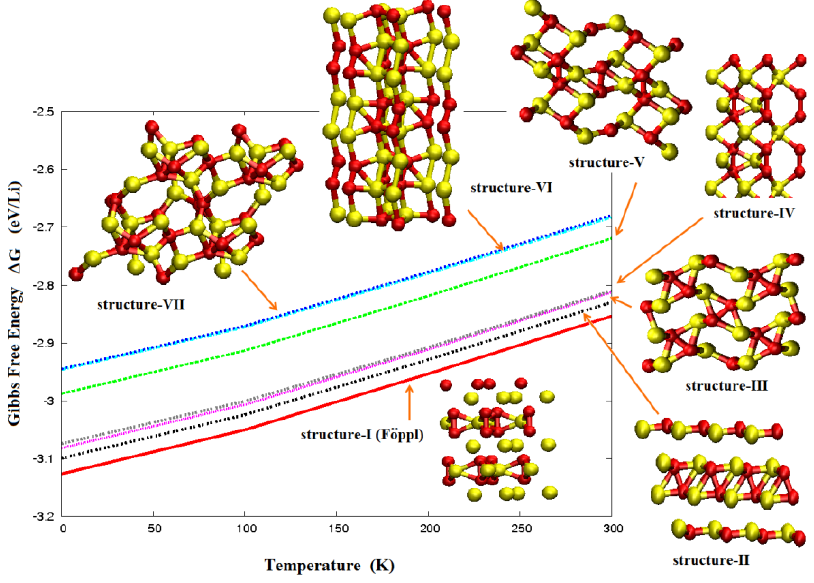
Figure 2. Selected Li 2 O 2 crystal structures found in simulations that are metastable with respected to the Föppl structure ( i.e. , structure-I) in terms of Gibbs free energy, ΔG (eV/Li) in the low temperature regime ( i.e. , T ≤ 300